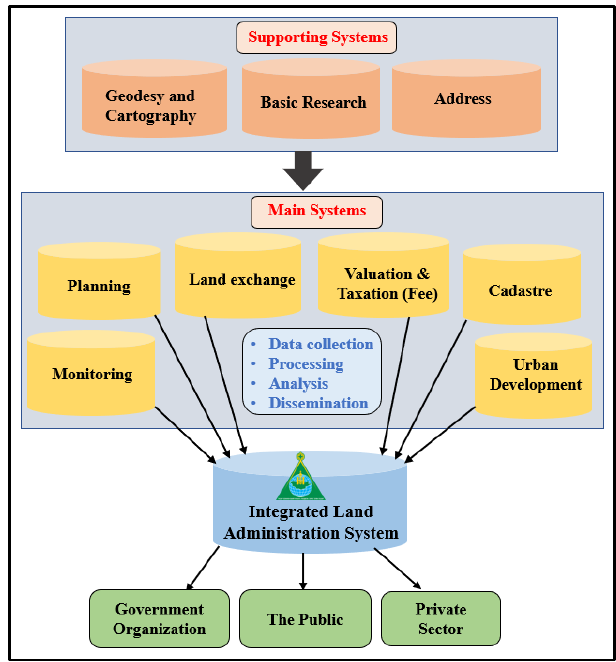
Figure 4. Integrated Land Administration System for Unified Land Database.